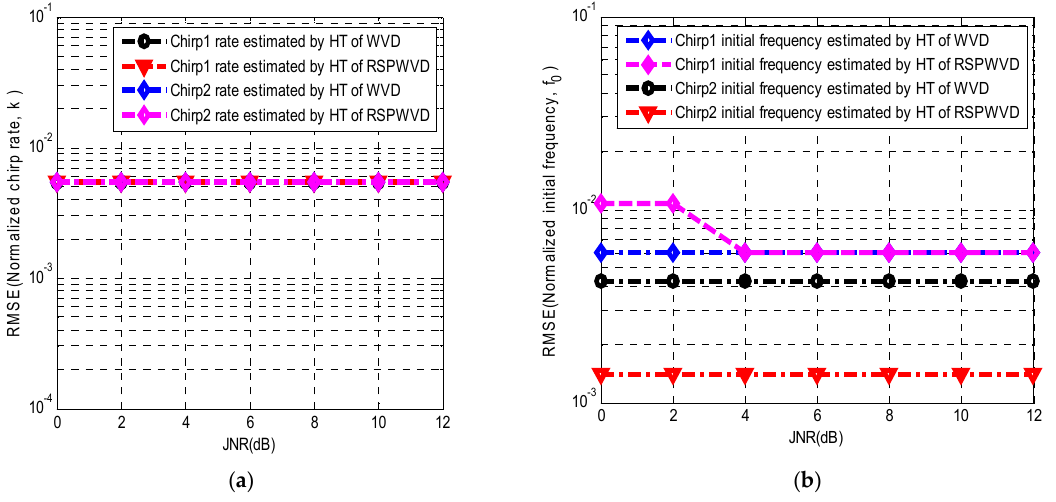
Figure 6. RMSE of the chirp rate and initial frequency estimation for chirp interferences present in BDS B1I signals by Hough transform combined by WVD and RSPWVD versus JNR. The C 0 / N is 43 dB-Hz. ( a ) RMSE of chirp rate. ( b ) RMSE of initial frequency.